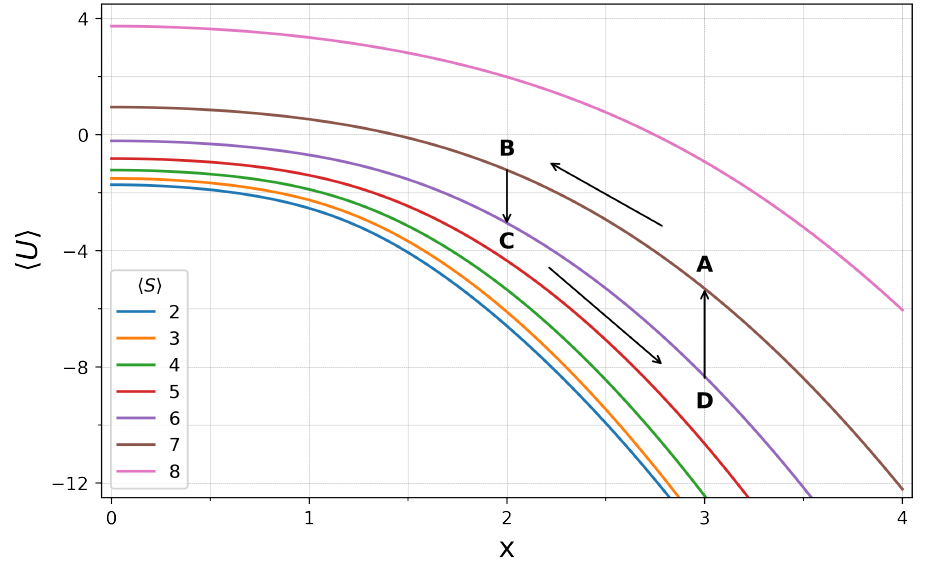
Figure 11. We displayed the general Otto cycle we have